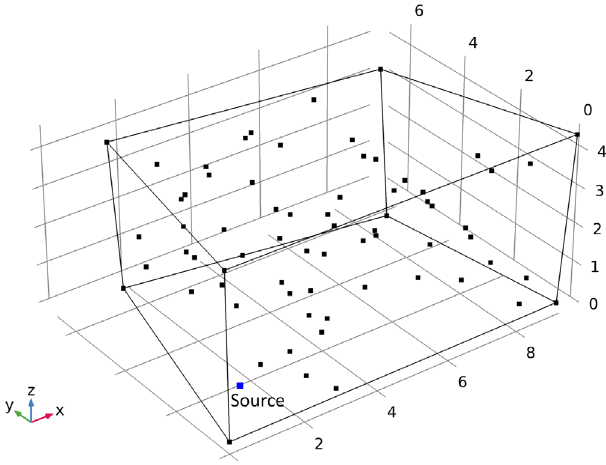
Figure 2. Geometry of the FEM model. The black dots represent the measurement points that are spread randomly in the